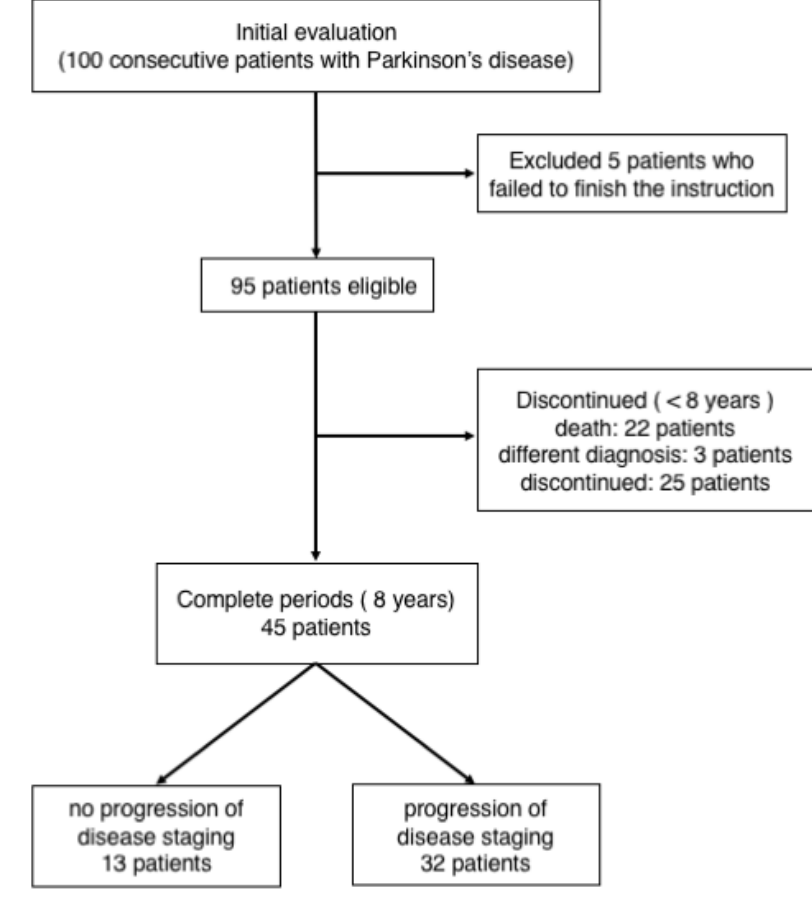
Figure 1. Patient selection procedure.